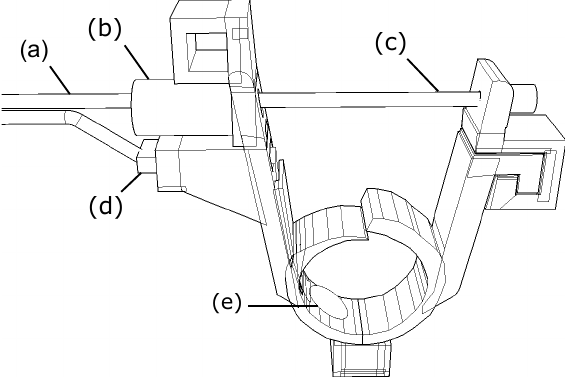
Figure 2. Main parts of the device. ( a ) Stimulation module. ( b ) Actuation and control unit. ( c ) Pneumatic Artificial Muscle (PAM).